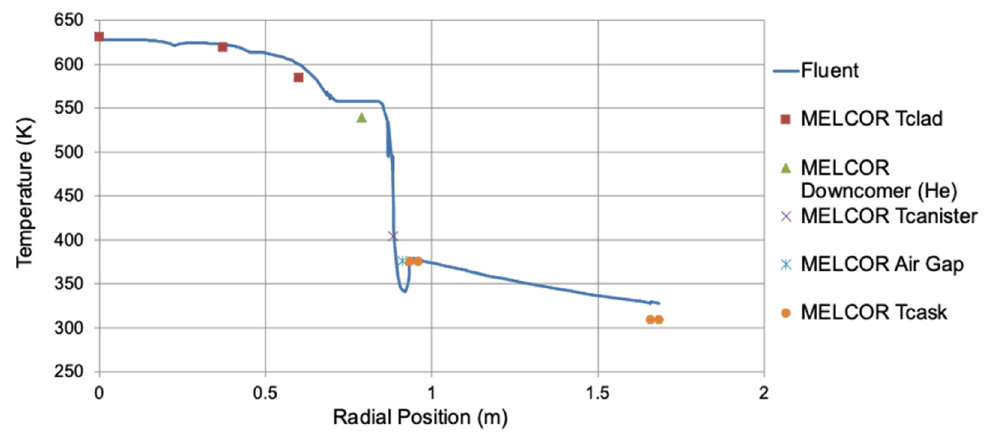
Figure 5. The MELCOR-FLUENT comparison—temperature radial profile.